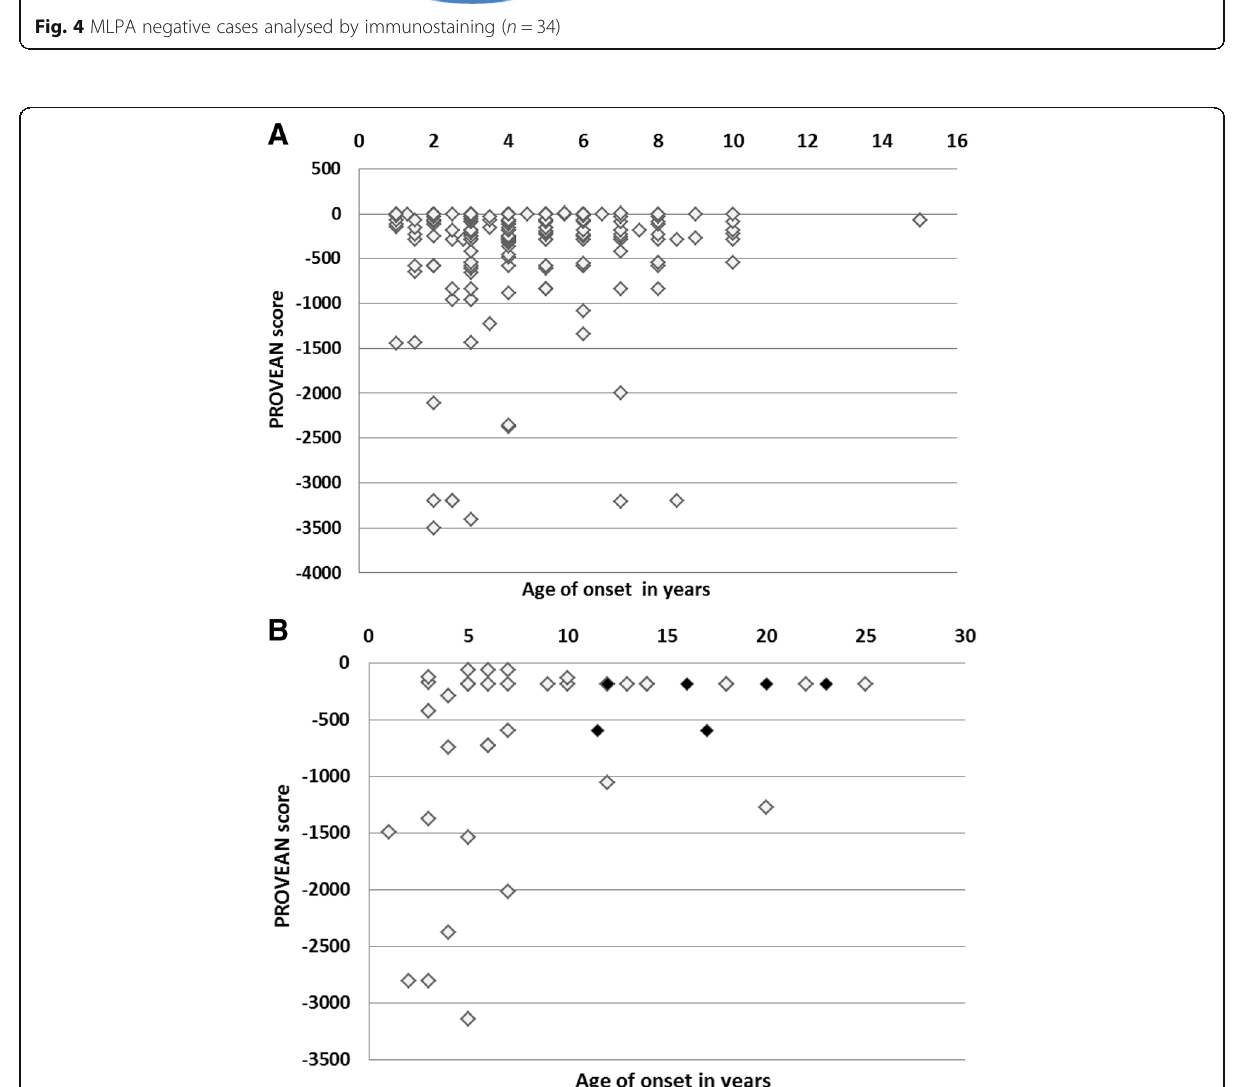
Fig. 5 Distribution of PROVEAN score on dystrophin protein ( a ) Effect of Out of frame mutation on dystrophin protein, ( b ) Effect of In-frame mutation on dystrophin protein. *Variants with a score equal to or below -2.5 are considered ‘ deleterious ’ *Variants with a score above -2.5 are considered ‘ neutral ’ ♦ Region with hinge III deletion ( b